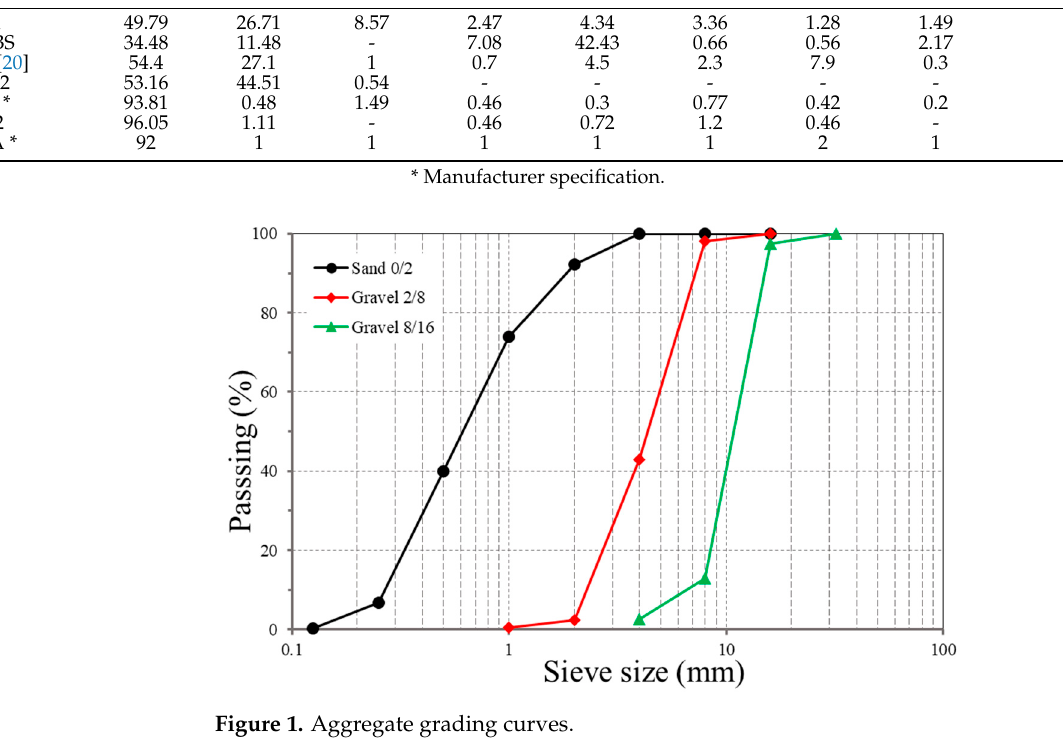
Table 1. Chemical compositions of source materials.